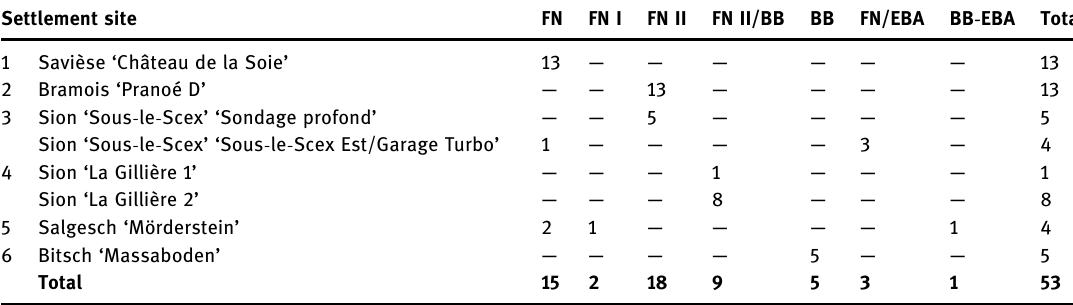
Table 2: Number of samples by site and by chronology Settlement